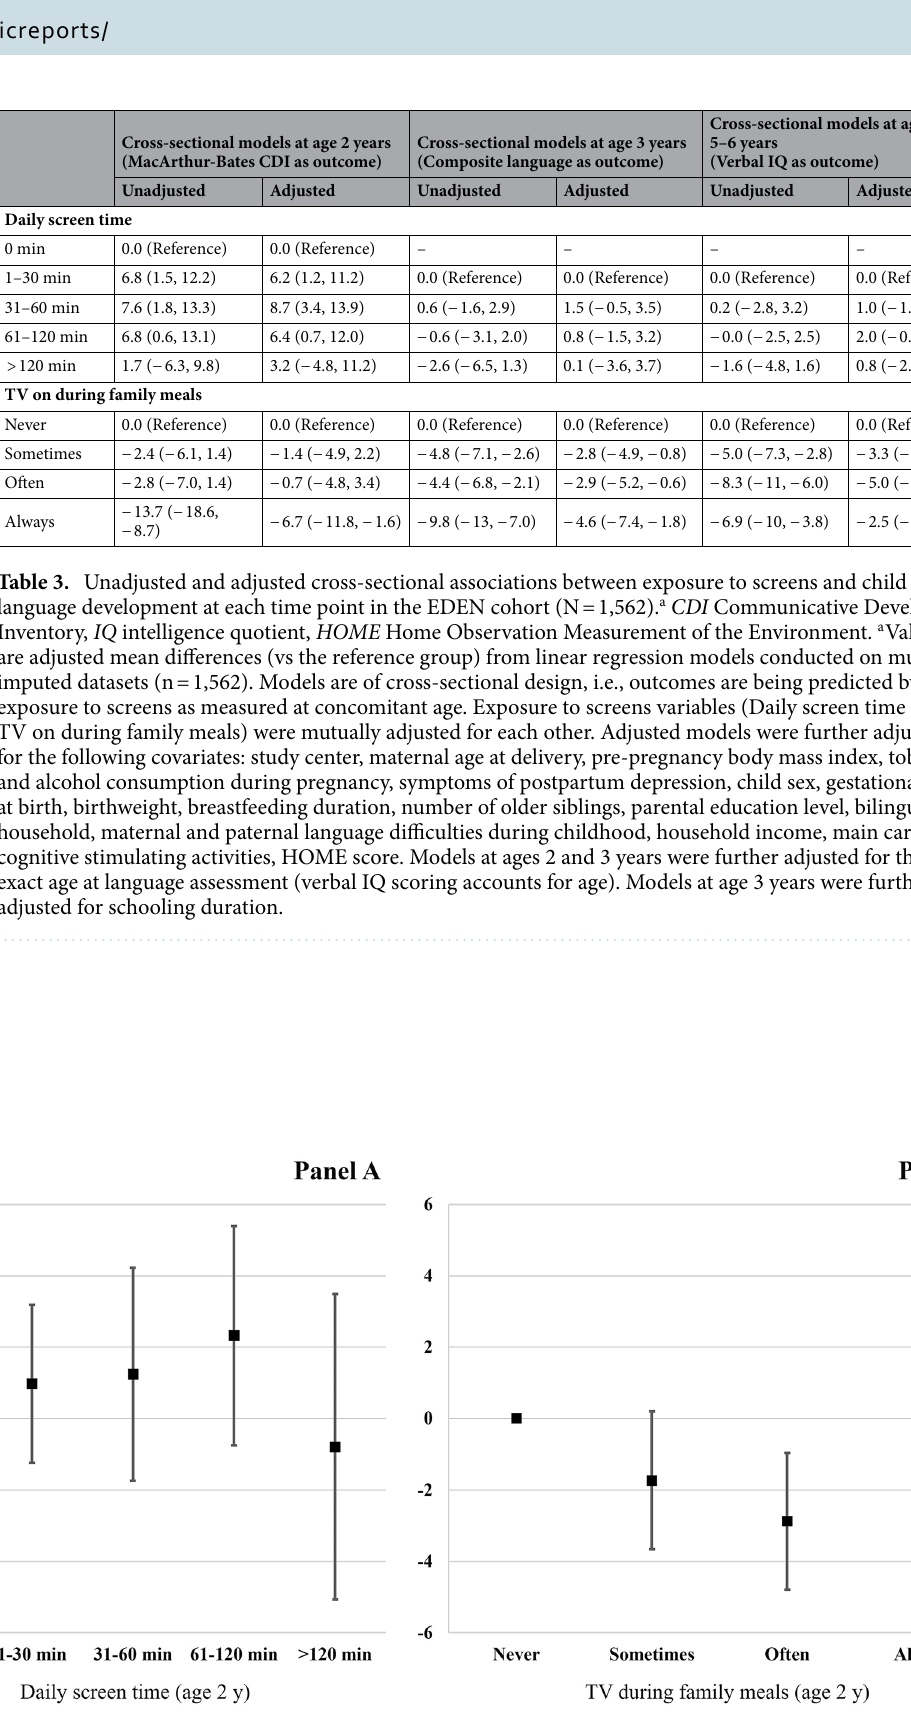
Figure 2. Mean difference in verbal IQ at age 5–6 years according to daily screen time (panel A ) and exposure to TV during family meals (panel B ) at age 2 years in the EDEN cohort. Error bars represent 95% confidence intervals around the mean difference estimates. P values for trend across categories are 0.60 and 0.002 for Panel A and Panel B, respectively. IQ intelligence